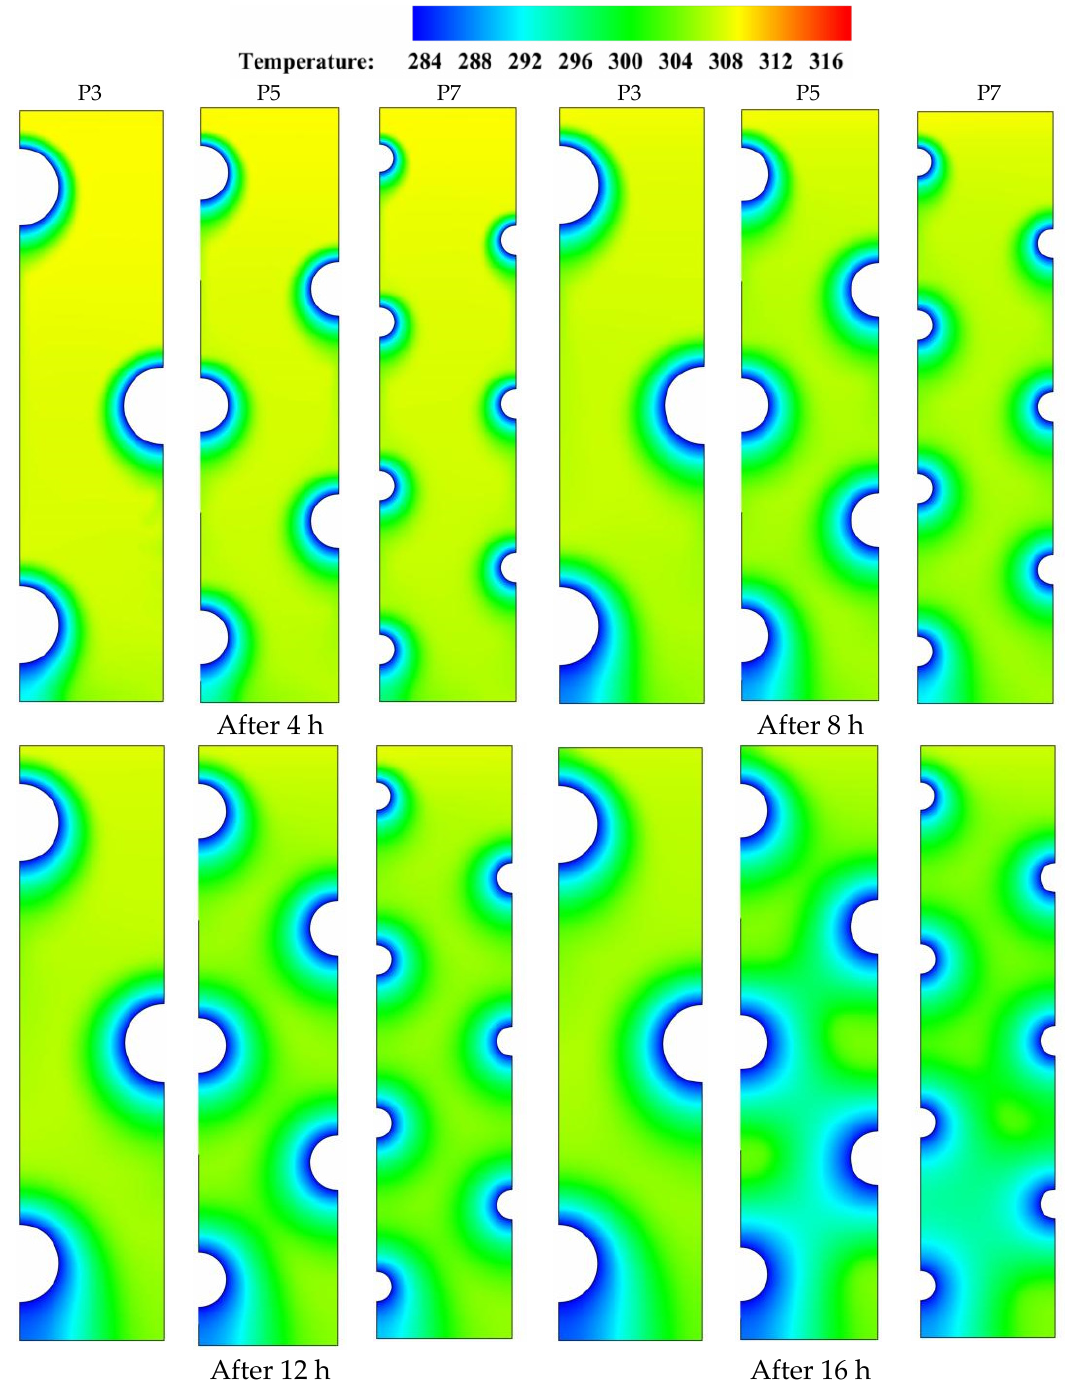
Figure 5. Contours of the PCM temperature distribution for three different HTF-tube arrangements of P3, P5, and P7 over multiple solidification durations.